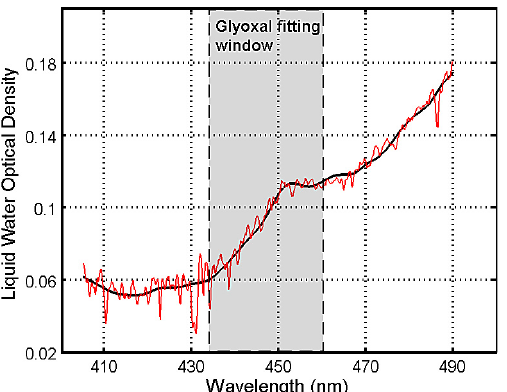
Fig. 4. DOAS fit of the liquid water optical density based on GOME-2 spectra recorded on 16 March 2007 in the Pacific Ocean. The calculated optical density is represented by the black curve and the fit residuals are plotted in red.